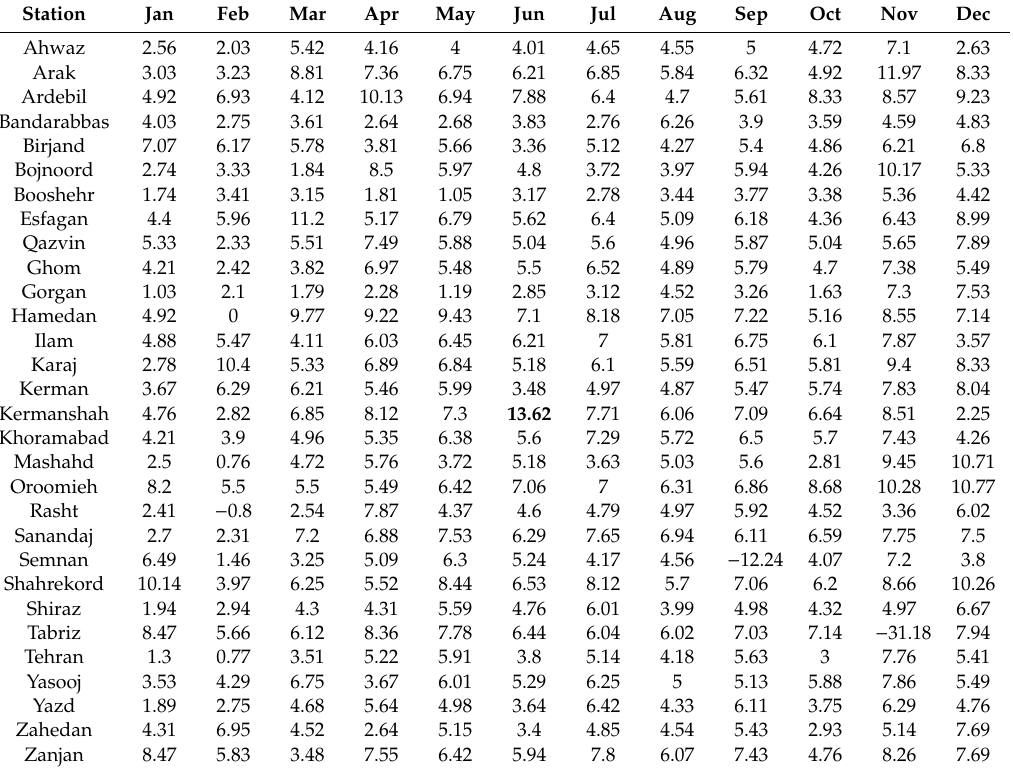
Table 4. Change percentages of ET 0 predicted for the period from 2046 to 2079 under the A1B scenario. Station